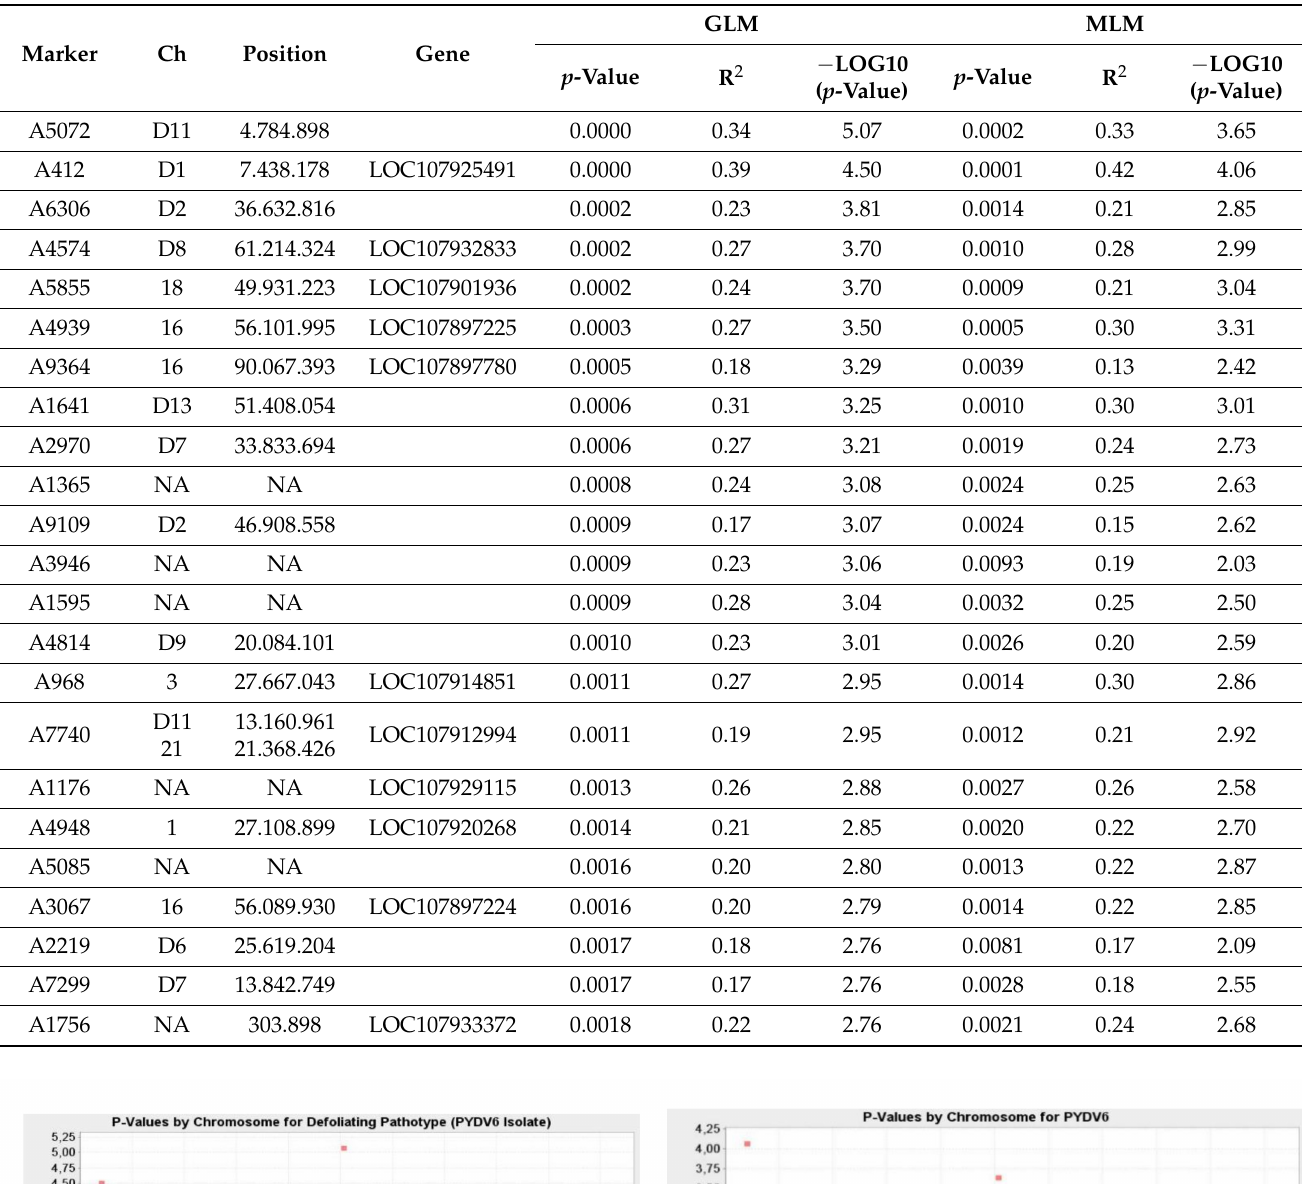
Table 4. Markers associated with defoliating pathotype (PYDV6 isolate) of Verticillium wilt disease.